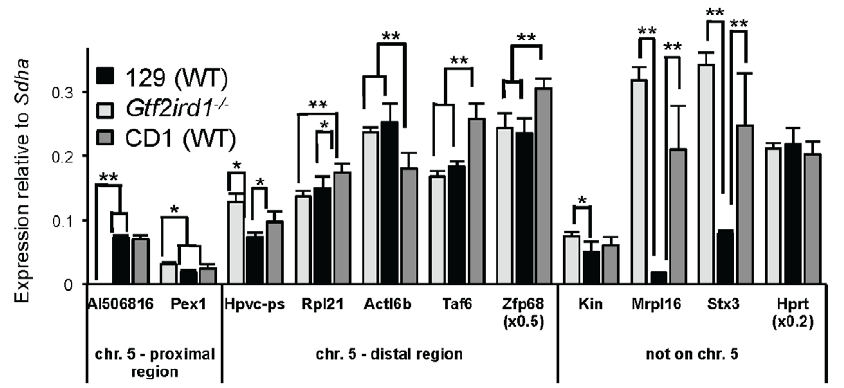
Figure 5. qRT-PCR of previously identified invitro targets of GTF2IRD1. Expression values were normalized to the housekeeping gene Sdha , and are depicted as a ratio of expression in Gtf2ird1 2 / 2 or Gtf2ird1 + / 2 mice relative to WT. No statistically significant differences in expression were detected between genotypes using Student’s t-test. A. Expression of Bmpr1b and Fgf15 in whole brain of P0 mice (n=3/genotype). B. Expression of previously identified in vitro targets of GTF2IRD1 in primary MEFs. MEFs were cultured from WT (n=3), Gtf2ird1 + / 2 (n=2), and Gtf2ird1 2 / 2 (n=1) E15.5 mouse embryos. Hmbs is a housekeeping gene and was used as a control. C. Expression of previously identified in vitro targets of GTF2IRD1 in whole brains. E18.5 (n=3/genotype), adult (WT, n=3; Gtf2ird1 2 / 2 , n=2) mice. Hprt is a housekeeping gene and was used as a